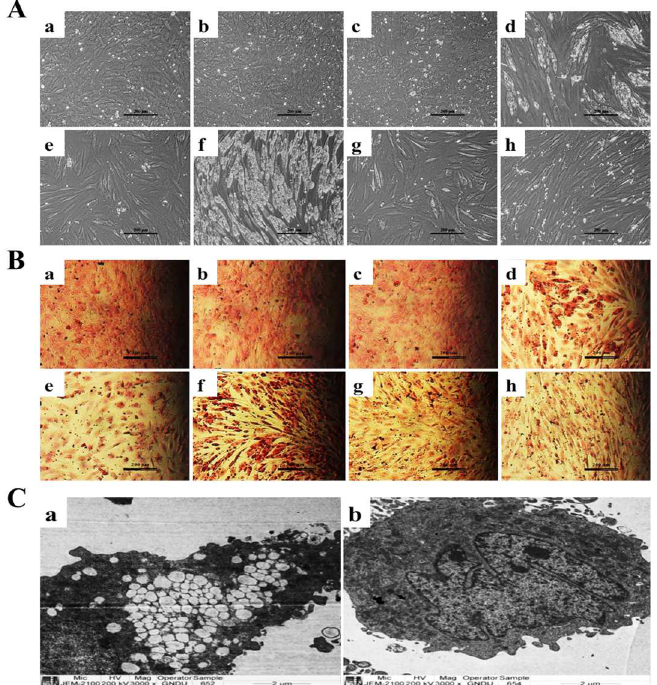
Fig 4. GSK3 β signaling is key to adipogenic differentiation of combined treatment of CPF and RA. (A) Phase-contrast micrographs showing(a) CT (b) DMSO (c) LiCl (10mM) (d) RA (2 μ M) (e) RA+ LiCl (e) RA + CPF (50 μ M) (f) RA+ CPF+ LiCl (g) CPF (B) Oil Red O stainedcells with similar treatment as above, indicatedthat LiCl completelyprevented adipogenicdifferentiation of combinedRA and CPF treatment. Scale- 200 μ m. (C) Transmission electron micrographs reiteratedthe completeblockadeof lipid accumulation followingLiCl addition to the combinedtreatment of RA and CPF (b) in comparisonto RA and CPF alone(a), suggestingGSK3 β as the key moleculein the adipogenic differentiation. Scale-